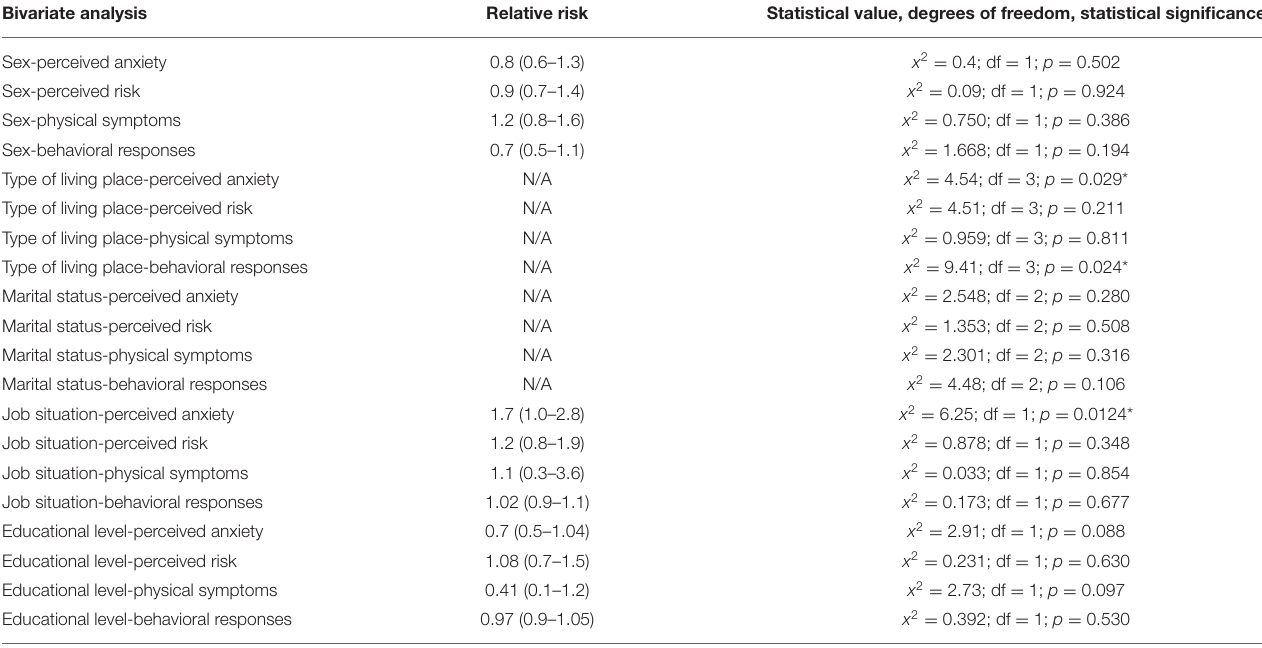
TABLE 3 | Bivariate analysis between sociodemographic variables and anxiety, perceived risk, physical symptoms, and behavioral responses. Bivariate analysis